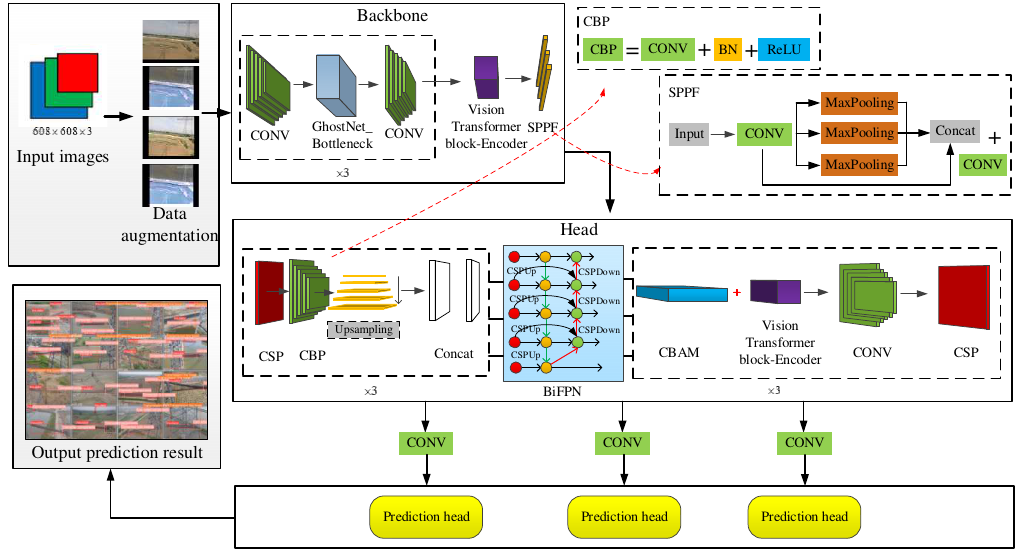
Figure 6. The structure diagram of Double—attention YOLO. The SPPF is a spatial pyramid pooling layer, which improves the multi-scale infor- mation fusion ability of the model by transforming input features of different sizes into vector information of specific dimensions. The specific structure of the SPPF is given on the right side of Figure 6. The main structure of the SPPF is convolution and concat oper- ation of max pooling. The head’s network structure abandons the FPN + PAN structure of the original YOLOv5 and uses the convolution output feature map down sampling to enhance the receptive field. The CBP structure is CONV + BN + ReLU, and then through the BiFPN feature, fusion structure, the input information of different sizes is fully ex-